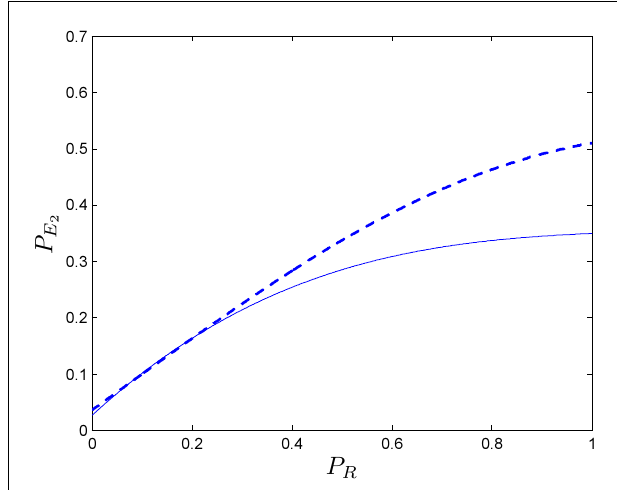
FIGURE 10 | In a one-dimensional case, the evolution of the bordering value (solid line) of those regions where the coupling phenomenon = 0.1 ). It can be seen that, in the appears is presented (with P E 1 two-dimensional case (dashed line), the positive coupling emerge with values of P E lower than the ones in the one-dimensional case. All values 2 have been obtained after 10,000 simulation